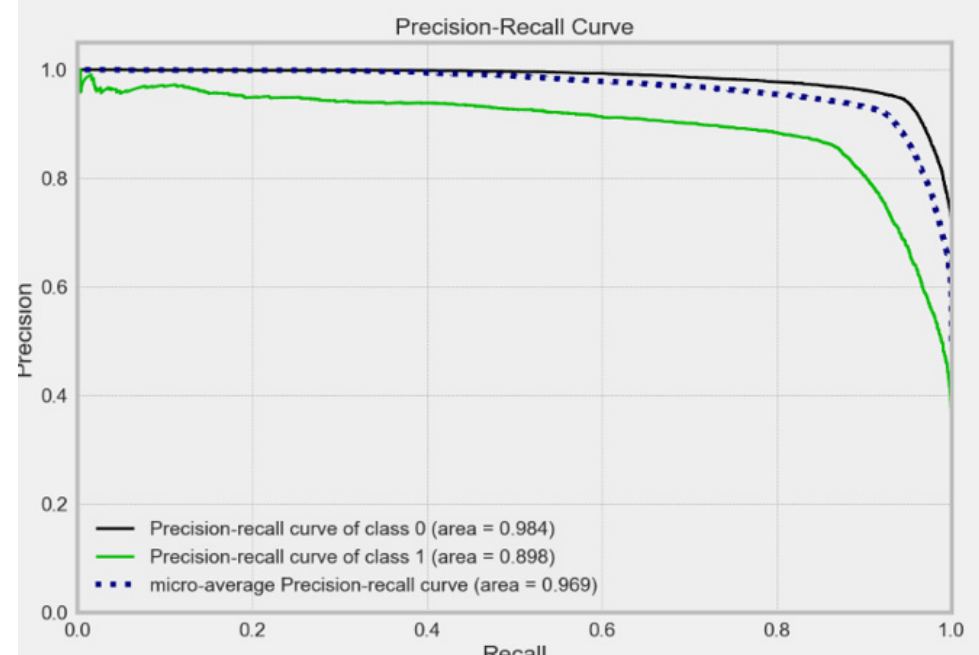
Figure 19. ROC Curves for random forest model.